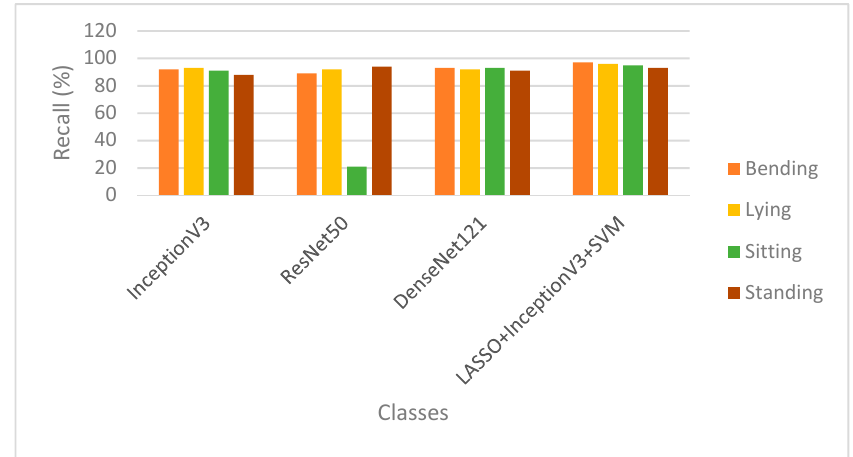
Figure 6. Recall the result of the classification per class classification result.